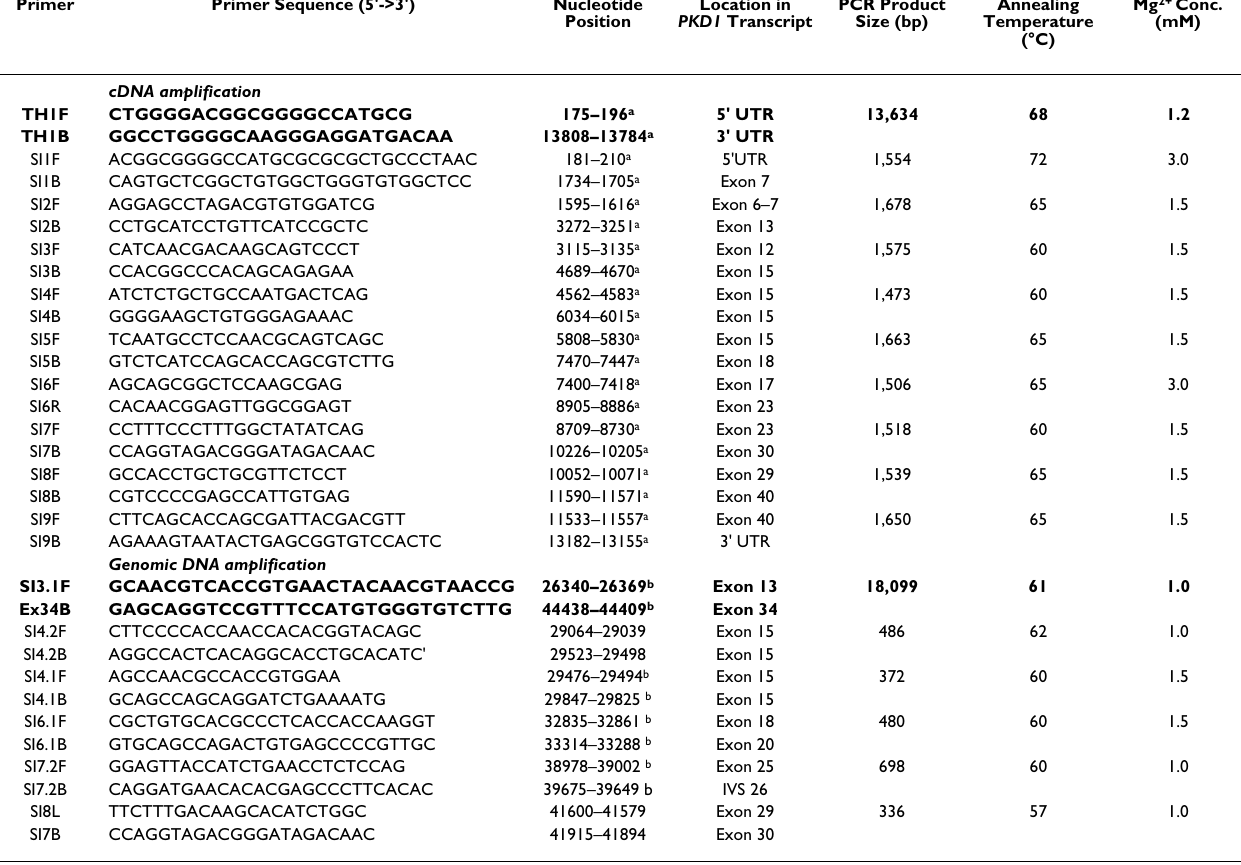
Table 1: PCR primers and conditions for amplifications of PKD1 cDNA and DNA